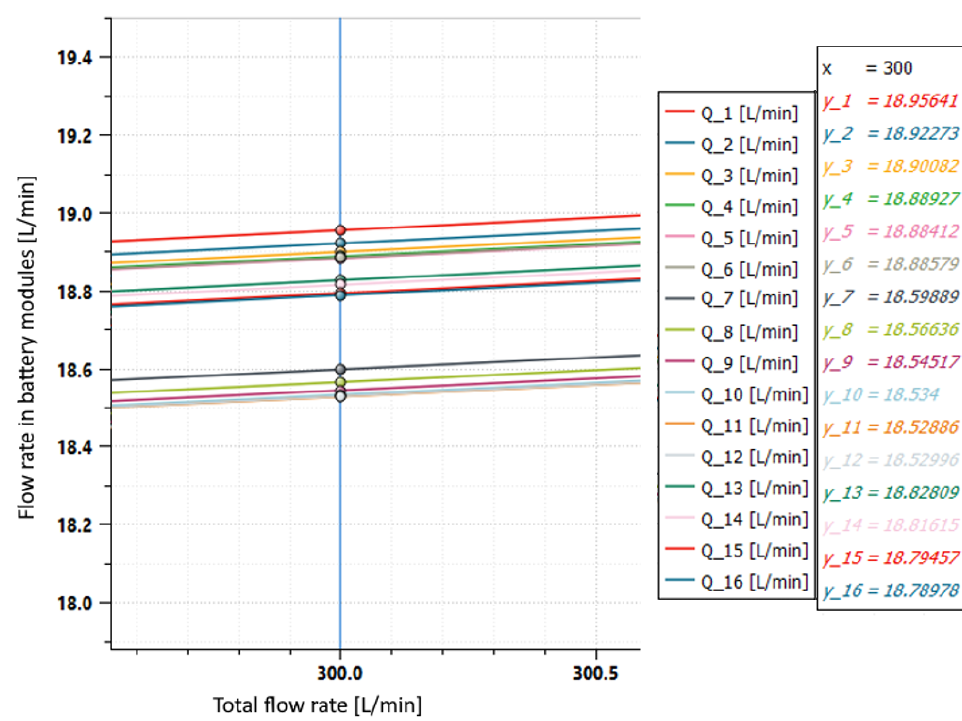
Figure 15. Flow rates in the individual battery modules in case of layout